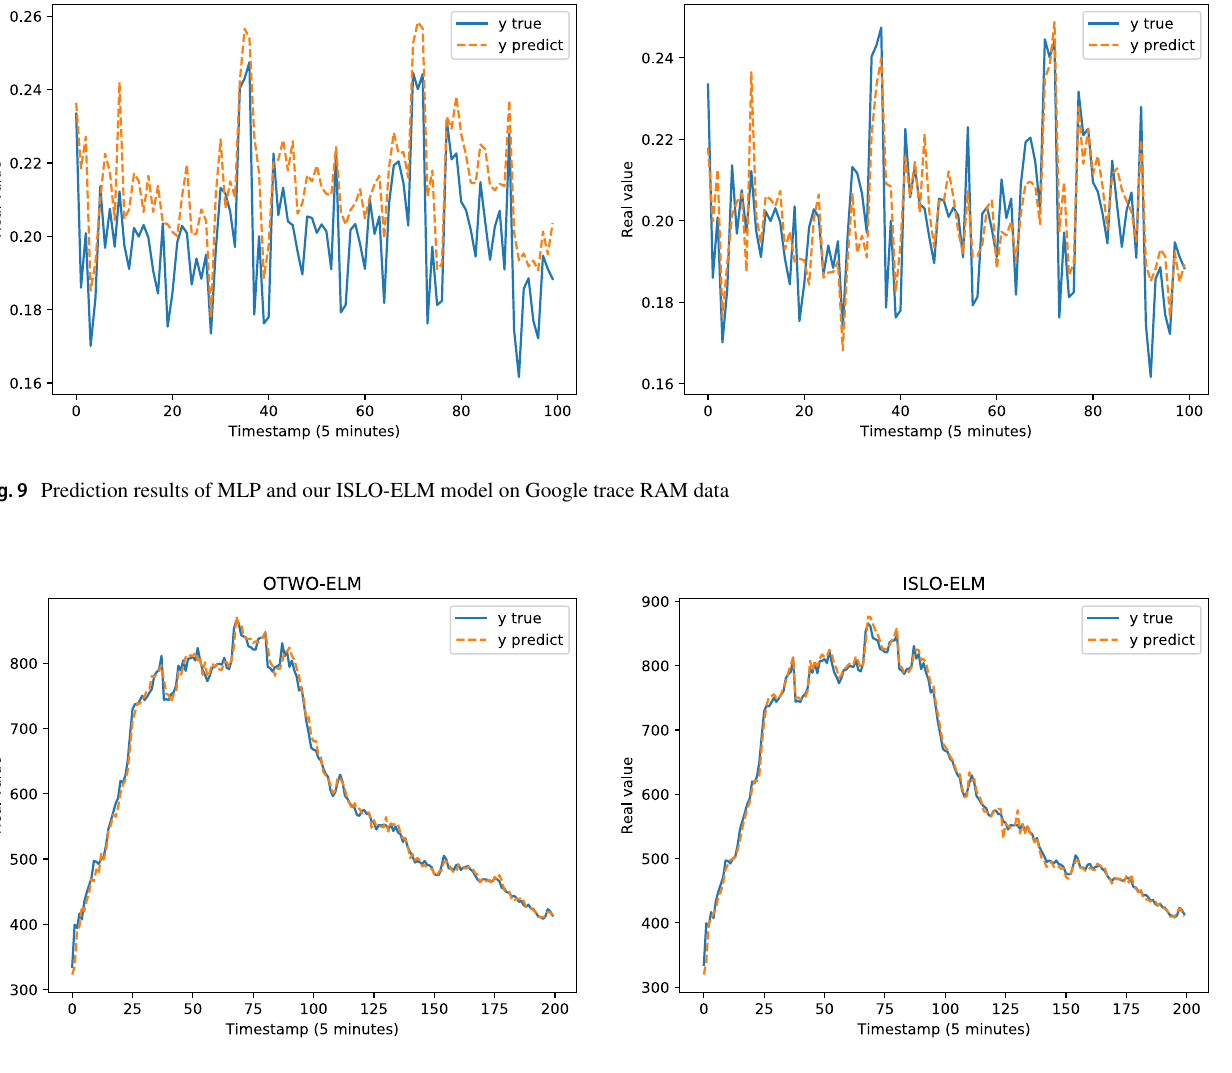
Fig. 10 Prediction results of OTWO-ELM and our ISLO-ELM model on the UK Internet traffic